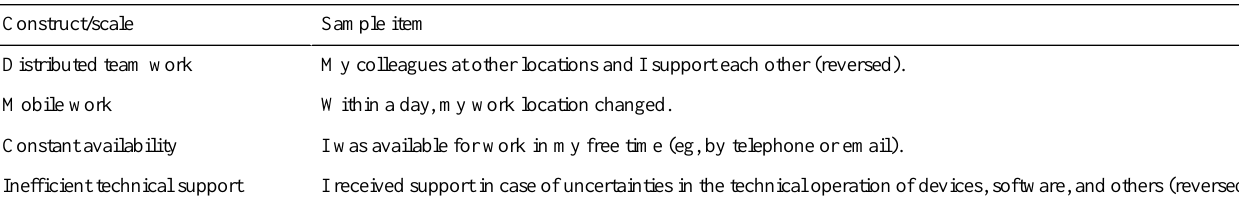
Table 1. Example items for the risks in digital work scale.